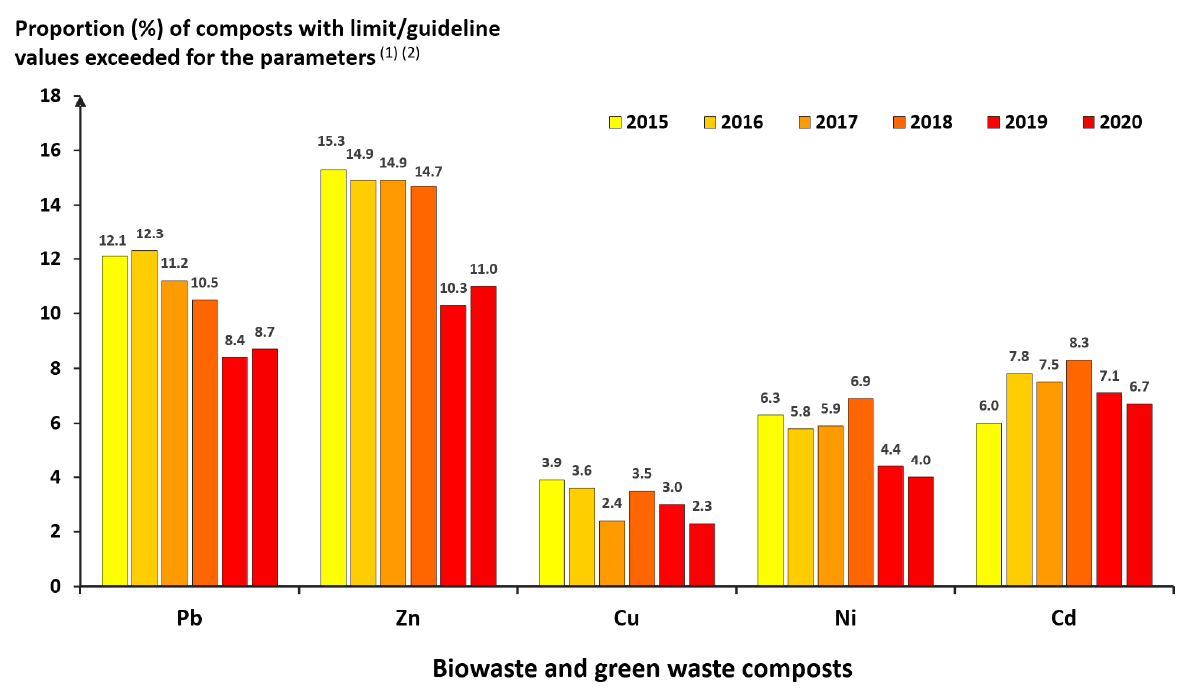
Figure 6. Proportion of quality-assured biowaste and green waste composts not suitable for organic farming due to exceedance of the heavy metal limits of the EU Organic Farming Ordinance (EU- ÖkoV) (composts according to RAL-GZ 251 Compost of BGK in Germany in 2015–2020) (1) (2) . (1) Limit values ( ≤ ) according to EU-ÖkoV—EU Regulations on organic farming (Regulation (EC) No. 889/2008, Annex 1 resp. 2021/1165, Annex 2; guideline values ( ≤ ) according to Bioland/Naturland guidelines (5/2014 to 3/2020). (2) Proportion of composts with limit/guideline values exceeded for the respective parameter = Proportion of composts unsuitable for organic farming in % of all composts of the RAL quality assurance 251 compost of BGK, n = 3272 in 2015, n = 3345 in 2016, n = 3361 in 2017, n = 3536 in 2018, n = 3677 in 2019, n = 3841 in 2020 (BGK 2016–2021).